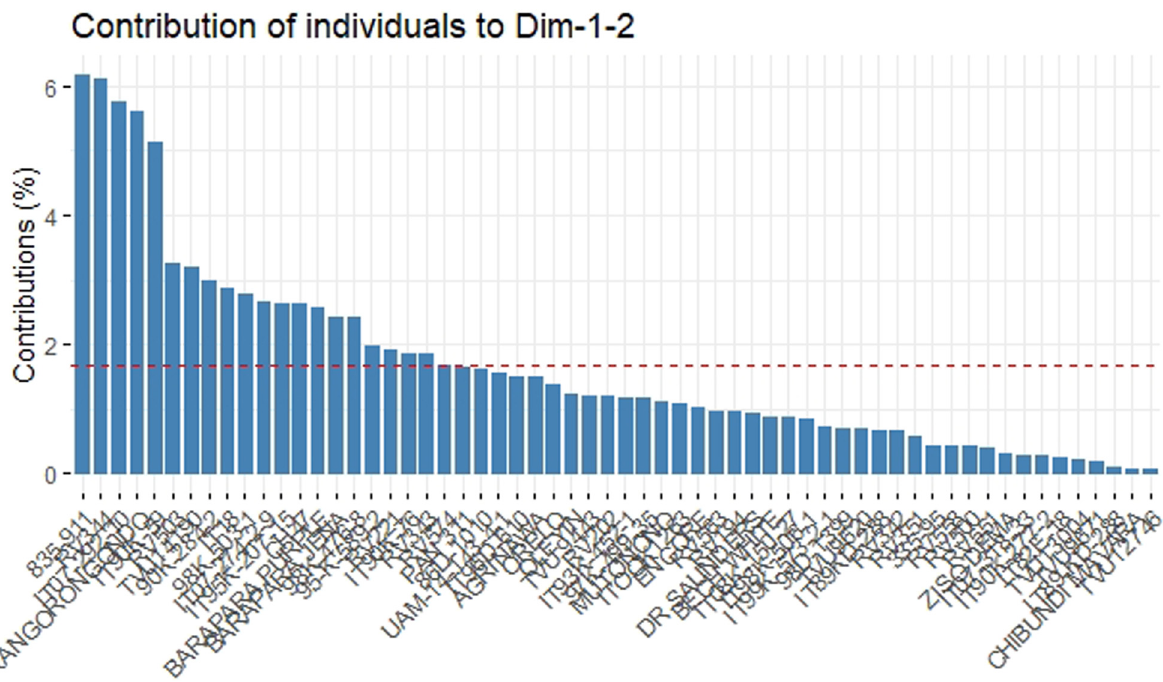
Figure 5: The contribution of 60 cowpea accessions screened to DIM 1 and 2.